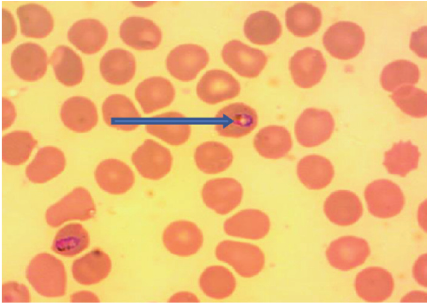
Figure 3: Ring trophozoites of Plasmodium falciparum